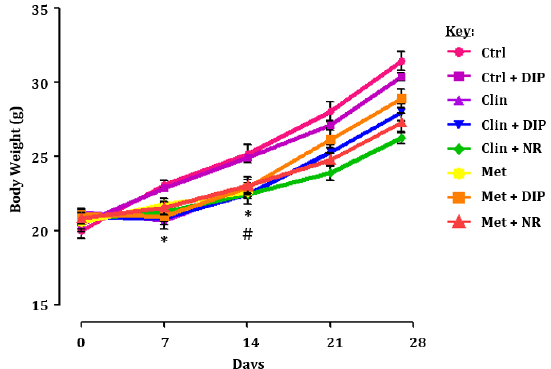
Figure 2. Body weight measurement after Dictyophora indusiata polysaccharide (DIP) treatment in an antibiotic ‐ treated mouse model at different time points. Mice receiving clindamycin (0.2 mg/0.2